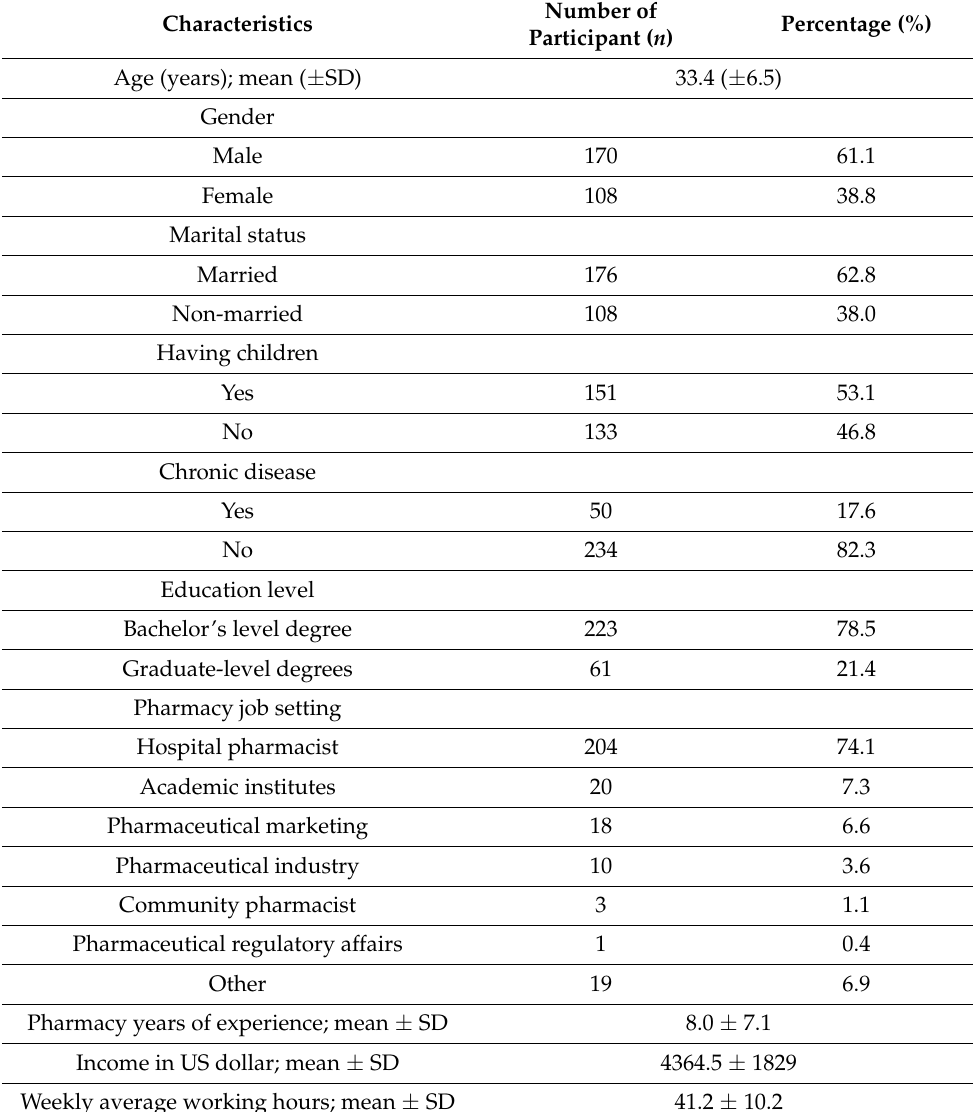
Table 1. Pharmacists’ Sociodemographic Characteristics in Saudi Arabia ( n = 284).